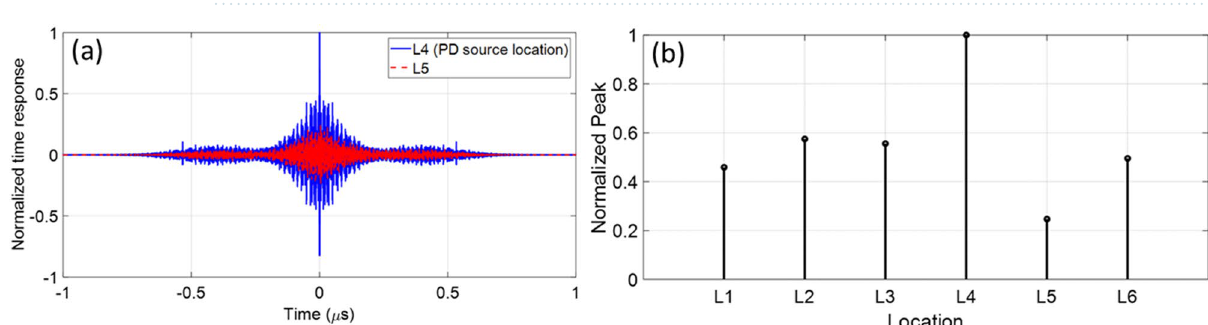
Figure 9. ( a ) The output signal of the pulse generator, ( b ) The dashed-red signal and the solid-blue signal show the impulse response measured at the position L 3 by the 70 GHz scope and reconstructed by the 3 GHz VNA.